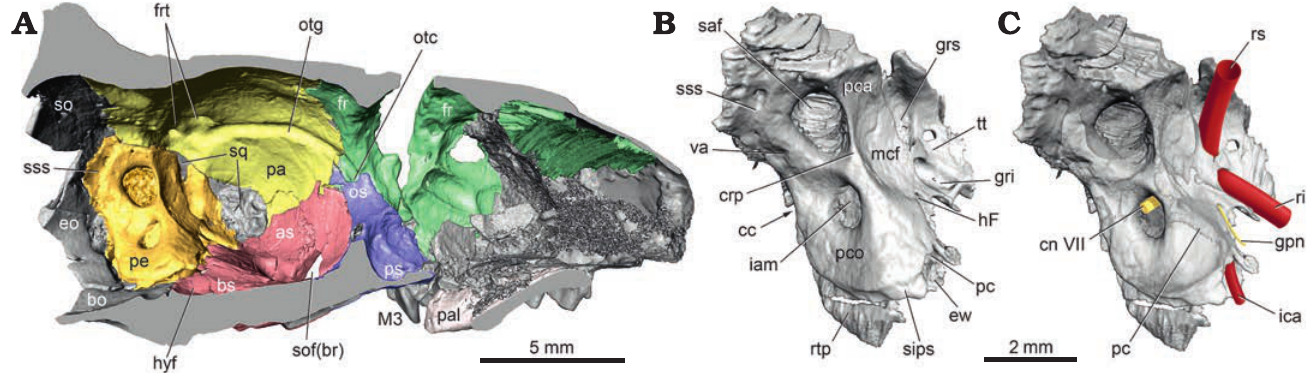
Fig. 3. Palaeoryctid mammal Eoryctes melanus Thewissen and Gingerich, 1989, UM 68074 (UM locality SC-133, Clarks Fork Basin, Wyoming, USA; early Wasatchian Land-Mammal Age, early Eocene), isosurfaces rendered from CT scans in medial view. A . Left endocranium (petrosal in gold; parietal in yellow; basi- and alisphenoid in red; pre- and orbitosphenoid in blue; frontal in green). B . Left petrosal. C . Left petrosal with neurovascular structures reconstructed (redrawn from Avizo segmentation; arteries in red; nerves in yellow). Abbreviations: as, alisphenoid; bo, basioccipital; bs, basisphenoid; cc, cochlear canaliculus; cn VII, cranial nerve VII; crp, crista petrosa; eo, exoccipital; ew, epitympanic wing; fr, frontal; frt, foramen for ramus temporalis; gpn, greater petrosal nerve; gri, groove for ramus inferior; grs, groove for ramus superior; hF, hiatus Fallopii; hyf, hypophyseal fossa; iam, internal acous- tic meatus; ica, internal carotid artery; M3, upper third molar; mcf, middle cranial fossa; os, orbitosphenoid; otc, orbitotemporal canal; otg, orbitotemporal groove; pa, parietal; pal, palatine; pc, promontory canal; pca, pars canalicularis; pco, pars cochlearis; pe, petrosal; ps, presphenoid; ri, ramus inferior; rs, ramus superior; rtp, rostral tympanic process; saf, subarcuate fossa; sips, sulcus for inferior petrosal sinus; so, supraoccipital; sof(br), sphenorbital fissure (broken); sq, squamosal; sss, sulcus for sigmoid sinus; tt, tegmen tympani; va, vestibular